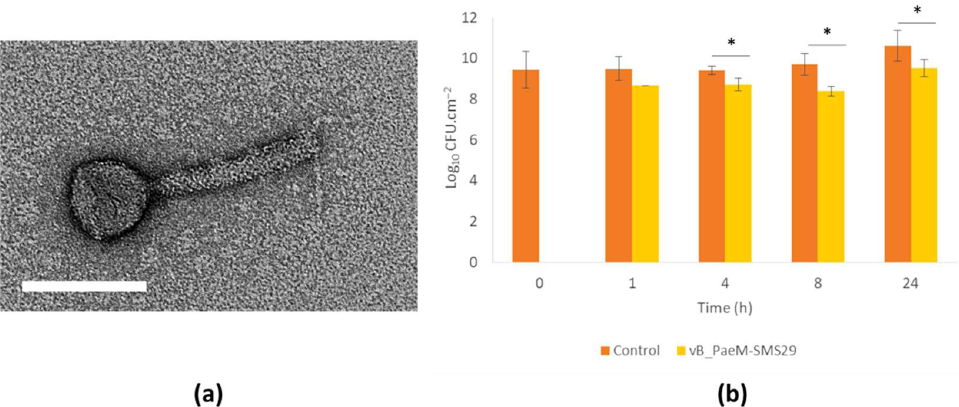
Figure 1. Phage vB_PaeP-SMS29 and its efficacy against 48 h-old P. aeruginosa PAO1 biofilms when delivered in a free form. ( a ) electron microscopy of vB_PaeM-SMS29, scale bar = 100 nm; ( b ) Number of cells (log 10 CFU · cm − 2 ) after different treatment periods with phage vB_PaeM-SMS29. * statistically different ( p < 0.05).